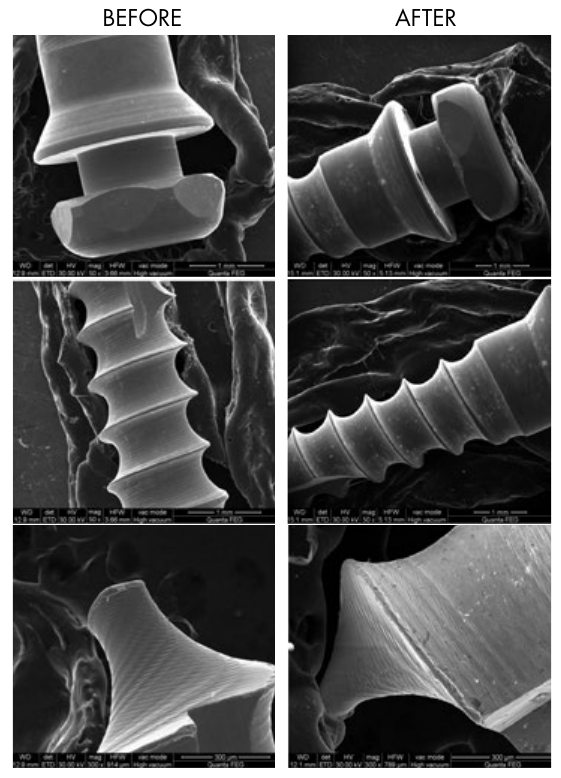
Figure 4. Back scattered SEM images of Group 2 mini-implants.